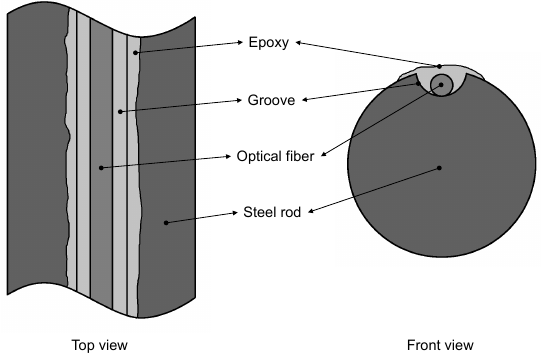
Figure 3. Schematic view of reinforcing steel bars instrumented with